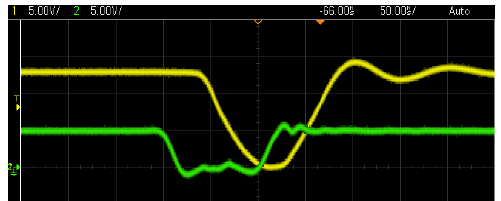
Figure 6. Estimated response of a 100 ns pulse.